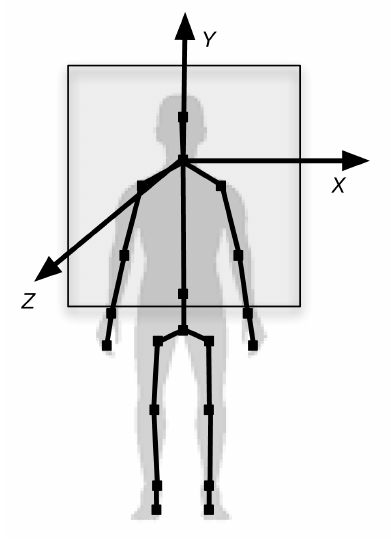
Figure 4. Coordinate system with respect to the skeleton